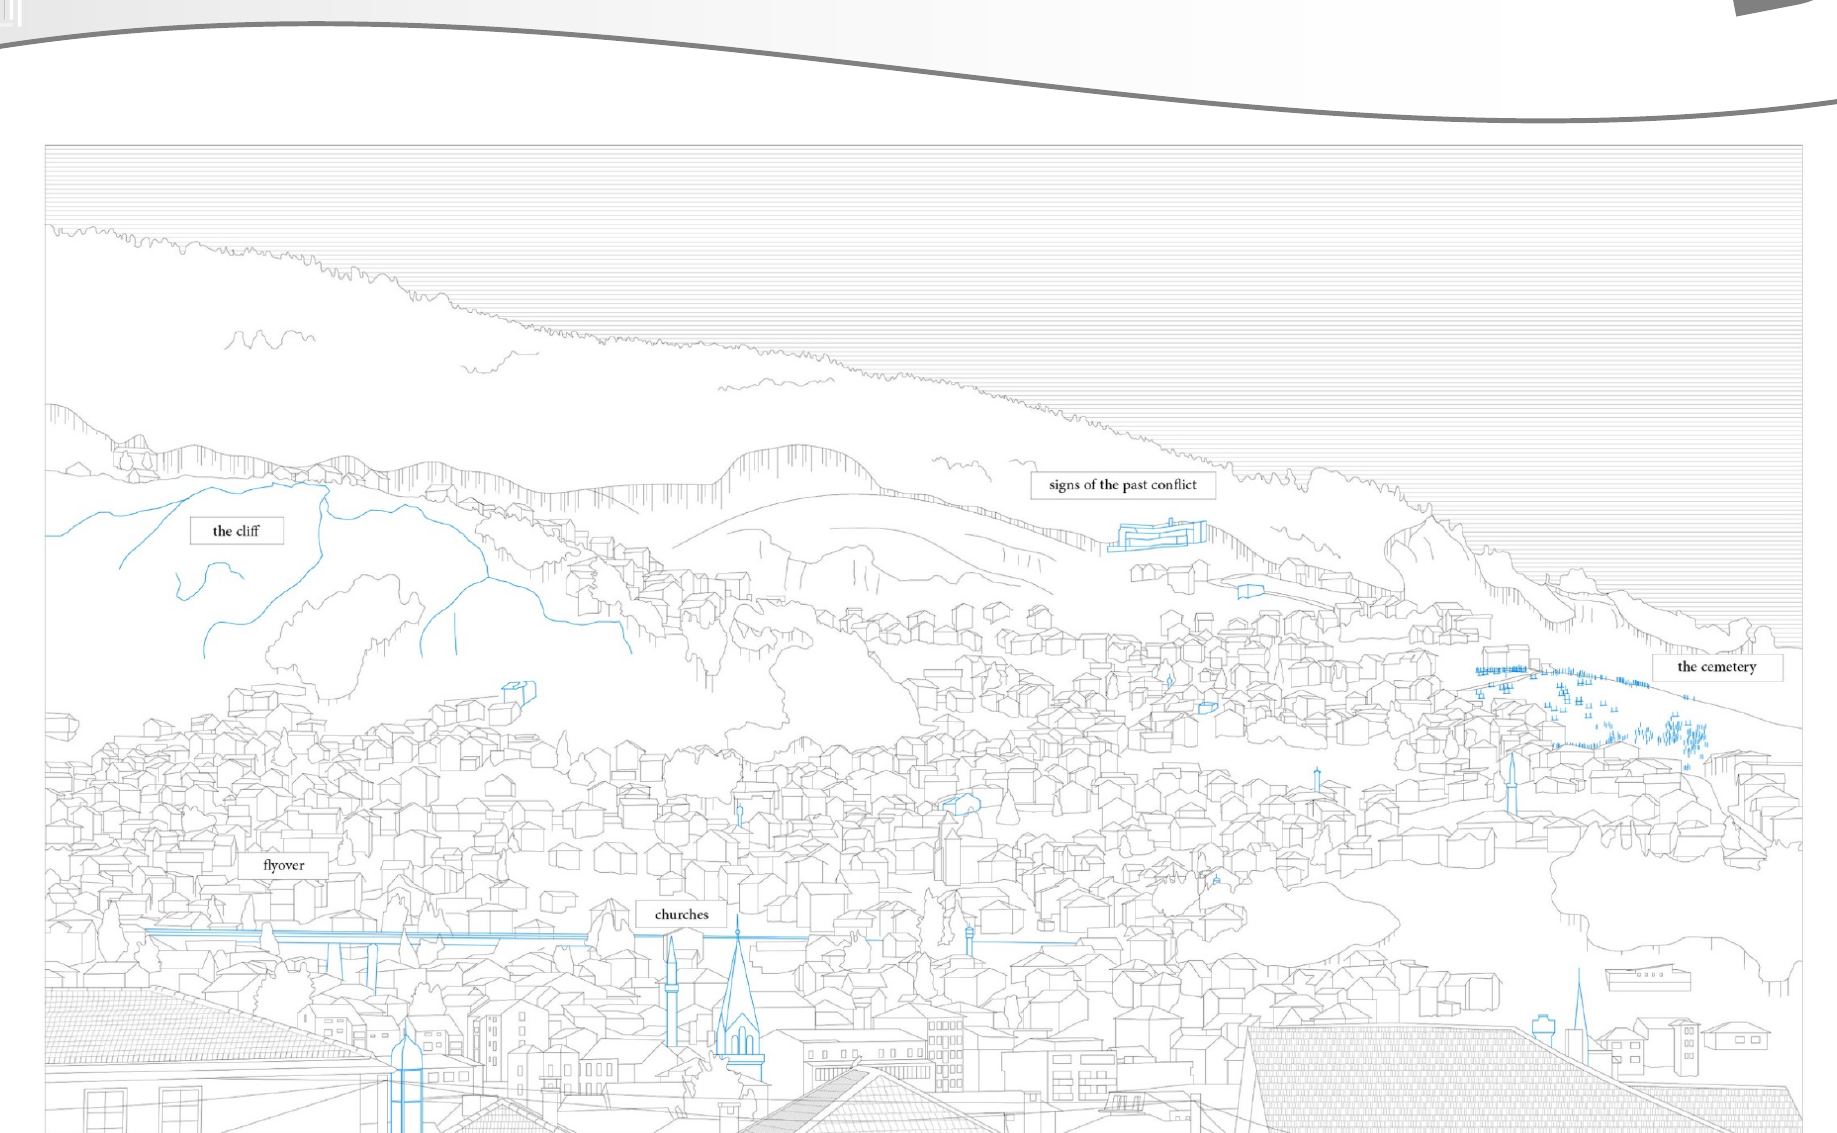
Figure 9: Širokača from the Stari Grad. The mahala sits on a north-facing slope, south of the Stari